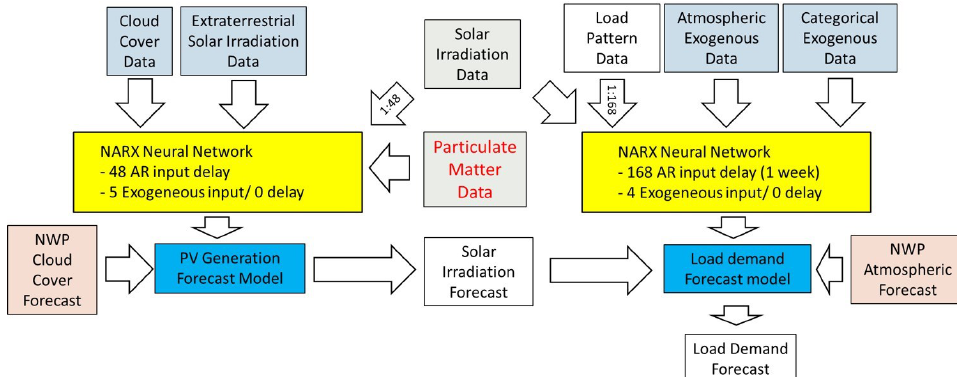
Figure 2. Load demand forecast considering BtM PV generation and particulate matter impact.